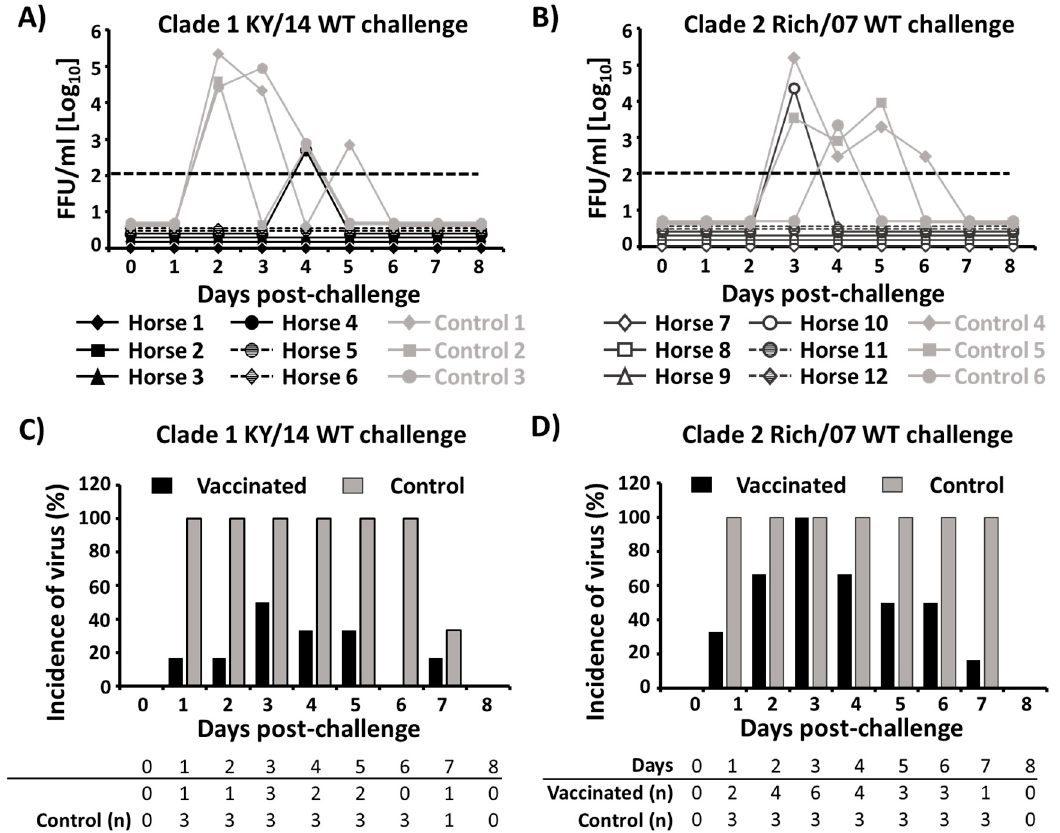
Figure 9. Viral shedding in vaccinated and control horses after EIV WT challenges: ( A , B ) Virus titers from nasopharyngeal swabs collected over 8 days after challenge with WT EIV were determined by immunofocus assay (FFU / mL) using an anti-NP monoclonal antibody (HB-65). Data represent individual results from each vaccinated (black) or control (gray) horse in group 1 ( A ) and group 2 ( B ). Dotted black lines represent the limit of detection of the assay (200 FFU / mL). ( C , D ) Embryonated chicken eggs were inoculated (100 µ L / egg, in triplicate) with nasopharyngeal swabs collected over 8 days after challenge with WT EIVs and presence of challenge virus was evaluated by hemagglutination assay (HA). Horses were considered positive when at least one egg showed progeny virus growth. Bars represent the incidence of positive vaccinated (black) or control (gray) horses in group 1 ( C ) and group 2 ( D ). Number of eggs ( n = 3) positive for the presence of WT EIV challenge virus are indicated at the bottom.